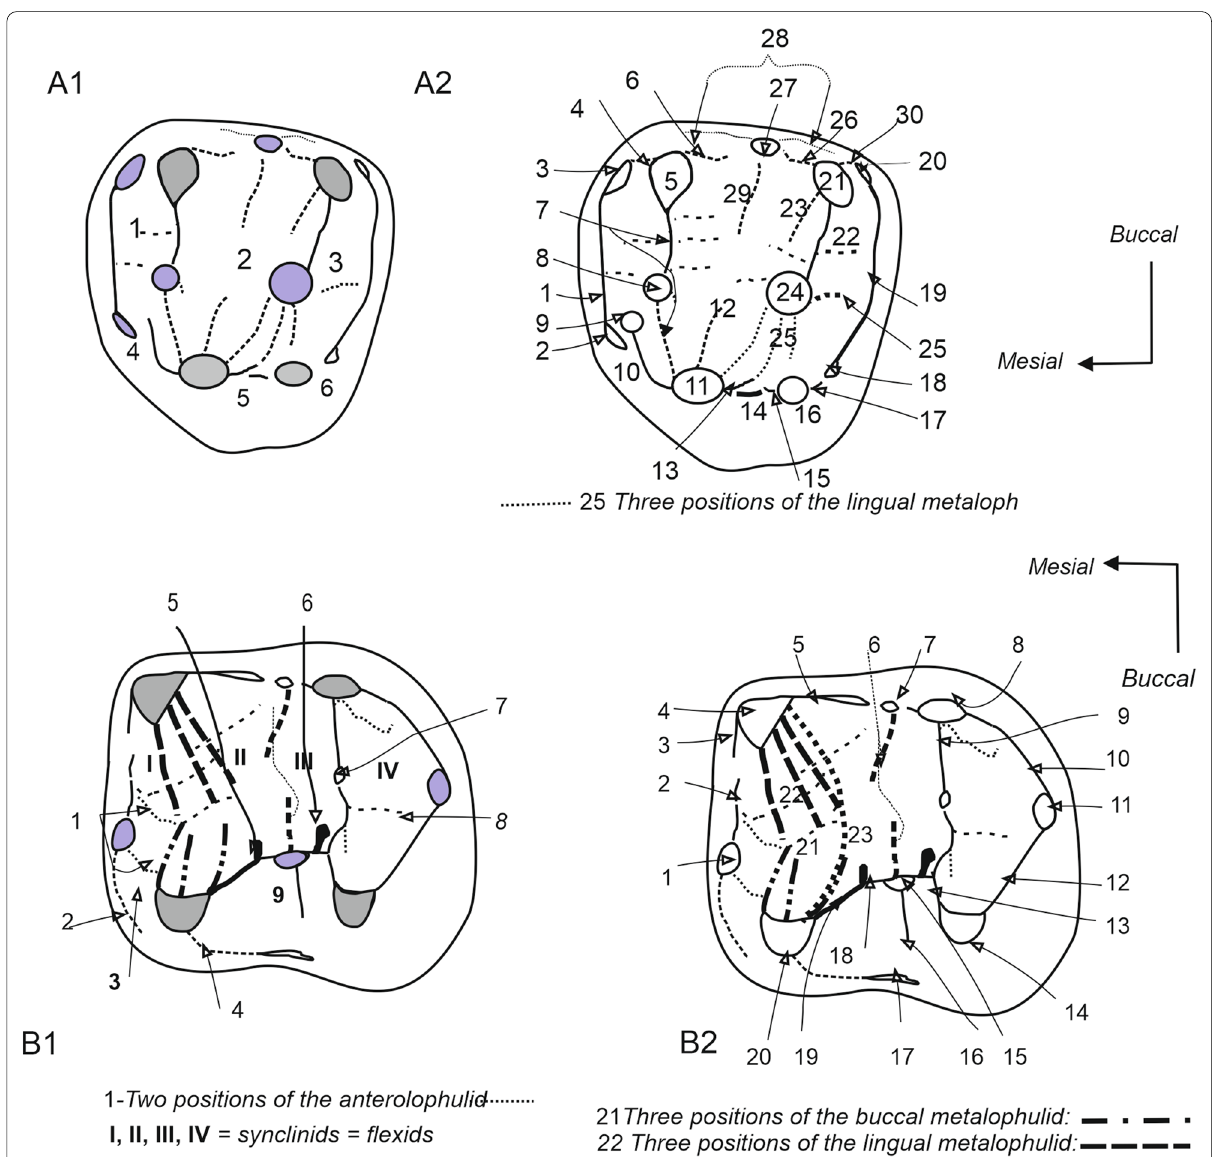
Fig. 2 Dental terminology (modified after Vianey‑Liaud & Marivaux, 2021). A Upper molars: Al, name of flexi. 1, anteroflexus; 2, mesoflexus; 3, posteroflexus; 4, antesinus; 5, sinus; 6, posterosinus. Main cusps colored in grey, conules and styles, in light purple. A2, crest and cusps. 1, anteroloph; 2, anterostyle; 3, parastyle; 4, preparacrista; 5, paracone; 6, postparacrista; 7, protoloph (buccal lingual); 8, paraconule; 9, preparaconule; + 10, preprotocrista; 11, protocone; 12, protocrista; 13, postprotocrista; 14, endoloph; 15, prehypocrista; 16, hypocone; 17, post‑hypocrista; 18, posterostyle; 19: posteroloph; 20: metastyle; 21, metacone; 22, buccal metalophule II; 23, buccal metalophule I; 24, metaconule; 25, three positions of the lingual metaloph; 26, premetacrista; 27, mesostyle; 28, ectocingulum; 29, mesoloph (buccal) ; 30, postmetacrista. B Lower molars. B1: Main cuspids colored in grey, conulids and stylids, in light purple, Names of flexids: I, anteroflexid; II III, mesoflexid; IV, posteroflexid. 1, two positions of + the anterolophulid; 2, anterocingulid; 3, antesinusid ; 4, protoconid spur; 5, premesoconid spur, or ridge or swelling; 6: postmesoconid spur, or ridge or swelling; 7, entoconulid; 8, extra‑ridges; 9, sinusid. .B2, other crestids and cuspids. 1, anteroconid; 2, anterolophid; 3, premetacristid; 4, metaconid; 5, postmetacristid; 6, mesolophid (lingual buccal); 7, mesostylid; 8, entoconid; 9, entolophid (lingual buccal); 10, posterolophid; 11, hypoconulid; + + 12, post‑hypocristid; 14, hypoconid; 15, mesoconid; 16, ectomesolophid; 17, ectocingulid, ectostylid; 18, ectolophid; 19, postprotocristid; 20, protoconid; 21, different paths of the buccal metalophulid: the most mesial and the medial one as buccal metalophulid I; 22, different paths of the lingual metalophulid I, and II for the most distal path; 23, path of the metalophulid II, with buccal part made with the